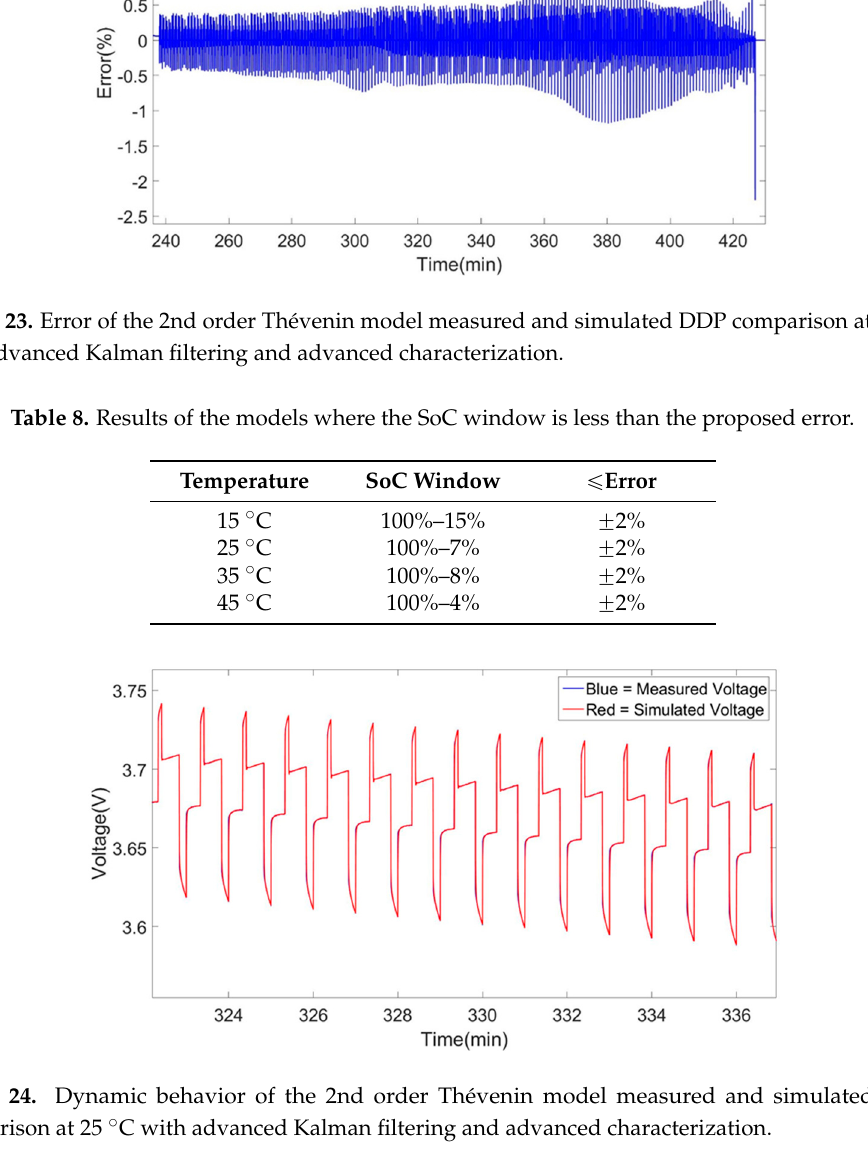
Figure 24. Dynamic behavior of the 2nd order Thévenin model measured and simulated DDP comparison at 25 °C with advanced Kalman filtering and advanced characterization.